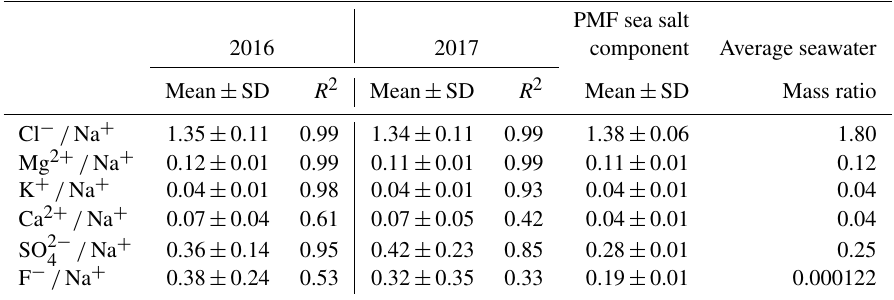
Table 2. Annual arithmetic mean mass ratios of Cl − , Mg 2 + , K + , Ca 2 + , F − and SO 2 − Pearson coefficient of the linear regression ( R 2 ) is reported. Mass ratios for average seawater from Seinfeld and Pandis (2006) are shown for comparison. Standard deviations are indicated as SD.